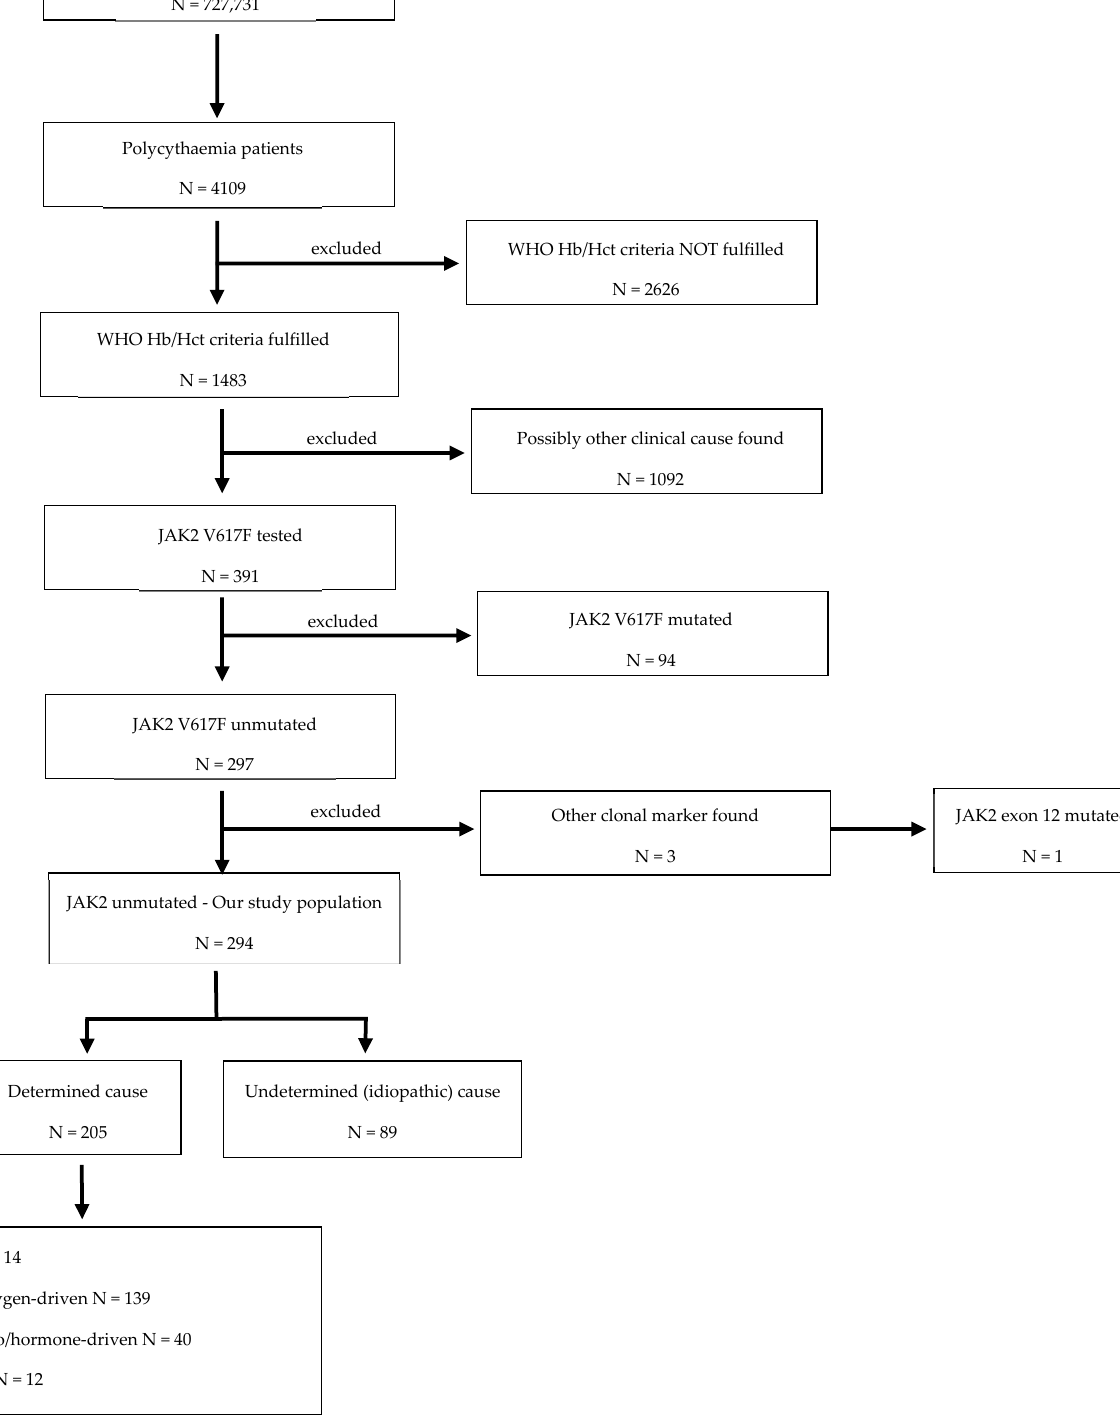
Figure 2. Polycythaemia. Study population, selection criteria for the study period 1 October 2008–31 July 2019.